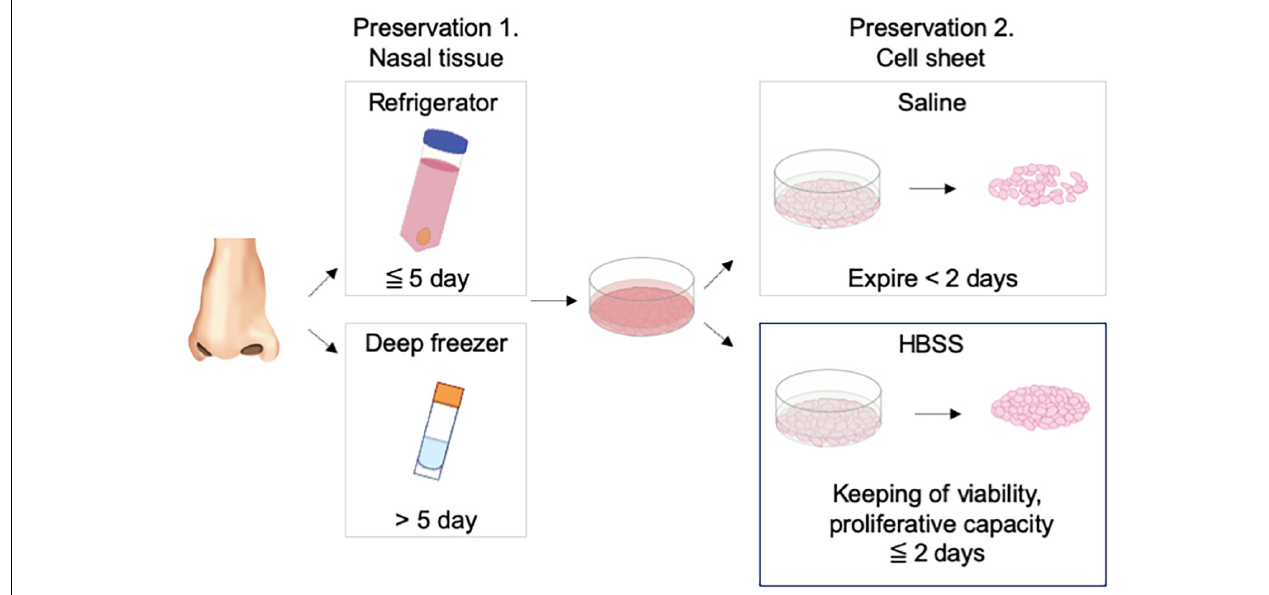
FIGURE 4 | Schematic diagram for the study. Nasal mucosal cell sheet could be fabricated from nasal mucosal tissue stored in a refrigerator or deep freezer and stored in Hank’s balanced salt solution for 2 days in a ready-to-use